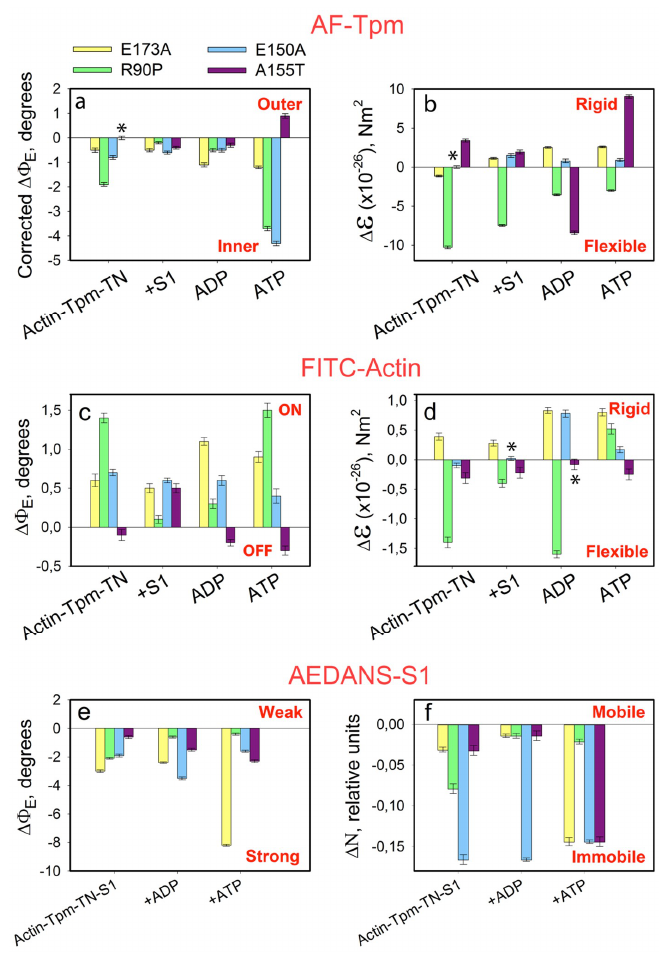
Figure 6. The effect of the E173A, R90P, E150A, and A155T mutations in γ-Tpm on the changes in the polarized fluorescence parameters observed at transition between the mimicked stages of the ATPase cycle at low Ca 2+ . The changes in the values for the angle Ф Е ( a , c , e ) from AF-Tpm, FITC-Actin, and AEDANS-S1, respectively, the changes in the values for the bending stiffness ε ( b , d ) determined on the basis of analysis of the polarized fluorescence from 5-IAF and FITC-phalloidin, respectively, and the changes in the values for N ( f ) from 1,5-IAEDANS are shown. The data represent differences in the values of Ф Е (ΔФ Е ), ε (Δε), and N (ΔN) between WTTpm and each of the mutant Tpms. Yellow, green, blue, and lilac columns show data for the filaments decorated with the E173A, R90P, E150A, and A155T mutant Tpms, respectively. They represent means of 8–10 ghost fibers for each experimental condition (see Section 4). The values of the ΔФ Е , Δε and ΔN for the E173A, R90P, E150A, and A155T mutant Tpms are significantly different from the corresponding values for WTTpm both in the absence and in the presence of nucleotides ( p < 0.05). Error bars indicate ± SEM. The asterisks were used to indicate statistically unreliable differences between the mutant ant wild-type Tpms.